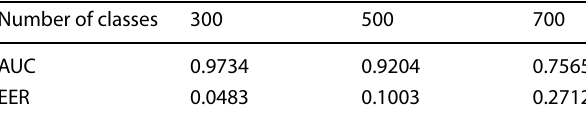
Table 3 The effect of various feature extraction structures on the classification performance of the proposed